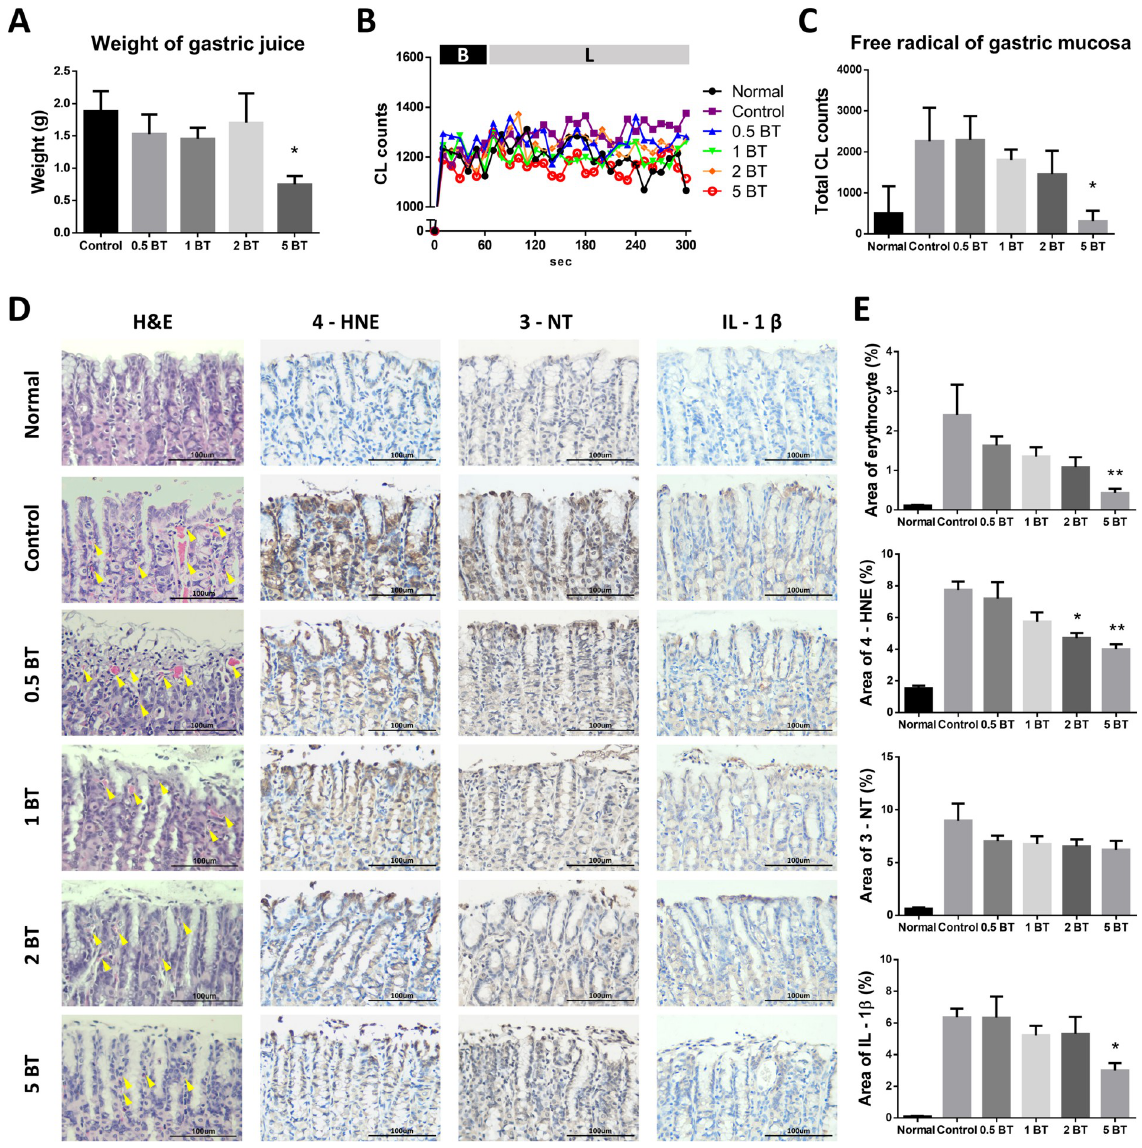
Fig 5. Effects of BT on pylorus ligation induced ulcer. The effects of drinking BT on pyloric ligation induced gastric juice secretion (A), the curves of CL counts from gastric mucosa free radicals content (B), and the free radicals content within gastric mucosa (C). B, baseline; L, luminol. (D) The histopathological evaluation of gastric mucosa. Yellow arrows indicate erythrocyte extravasation. (E) Quantitative analysis of histopathology. The area of different targets were shown as percentage (%). Gastric juice, gastric mucosa free radicals, erythrocyte extravasation, and area of IL-1 β were decreased in 5 BT group. Area of 4-HNE were decreased in 2 BT and 5 BT groups (n = 8). The data are mean ± SEM and analyzed by one-way ANOVA. � P < 0.05; �� P <